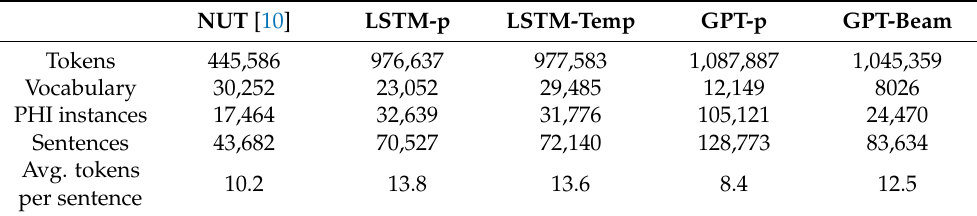
Table 4. Summary statistics of the synthetic corpora in reference to a real corpus (NUT).